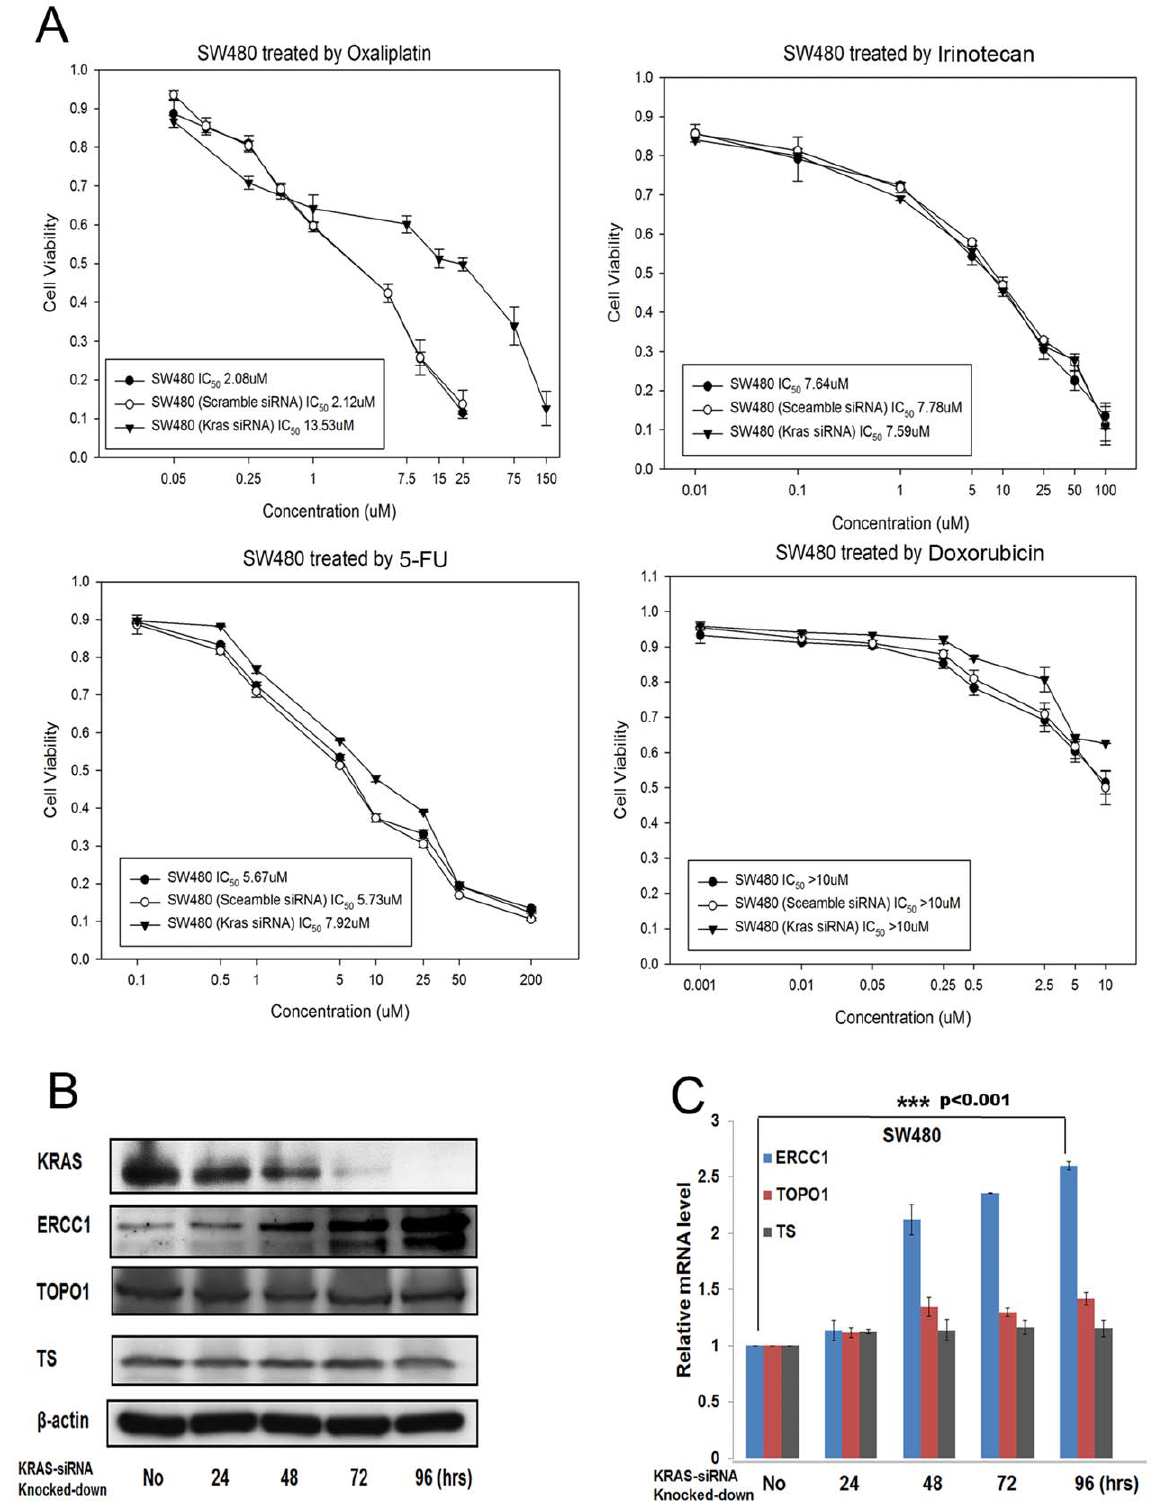
Figure 2. Knocking down KRAS expression in other KRAS-mutant subtype (G12V) CRC cells results in oxaliplatin resistance and ERCC1 upregulation. (A) KRAS-knocked-down SW480 G12V cells were more resistant to oxaliplatin, but have the same sensitivity to irinotecan, 5FU, and doxorubicin than parental SW480 G12V cells, as demonstrated by MTT assay. (B) The protein level of ERCC1, but not those of TOPO1 or TS, was upregulated after SW480 G12V cells were knocked-down by KRAS siRNA. (C) The mRNA level of ERCC1, but not those of TOPO1 or TS, was upregulated after SW480 G12V cells were knocked-down by KRAS siRNA. ***: p , 0.001.